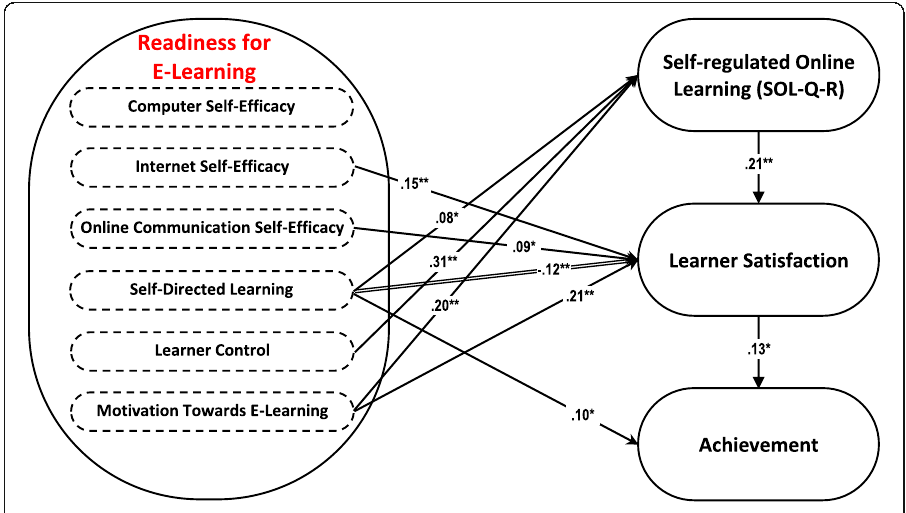
Fig. 2 Standardized coefficients observed in suggested model (* p < .01, ** p <